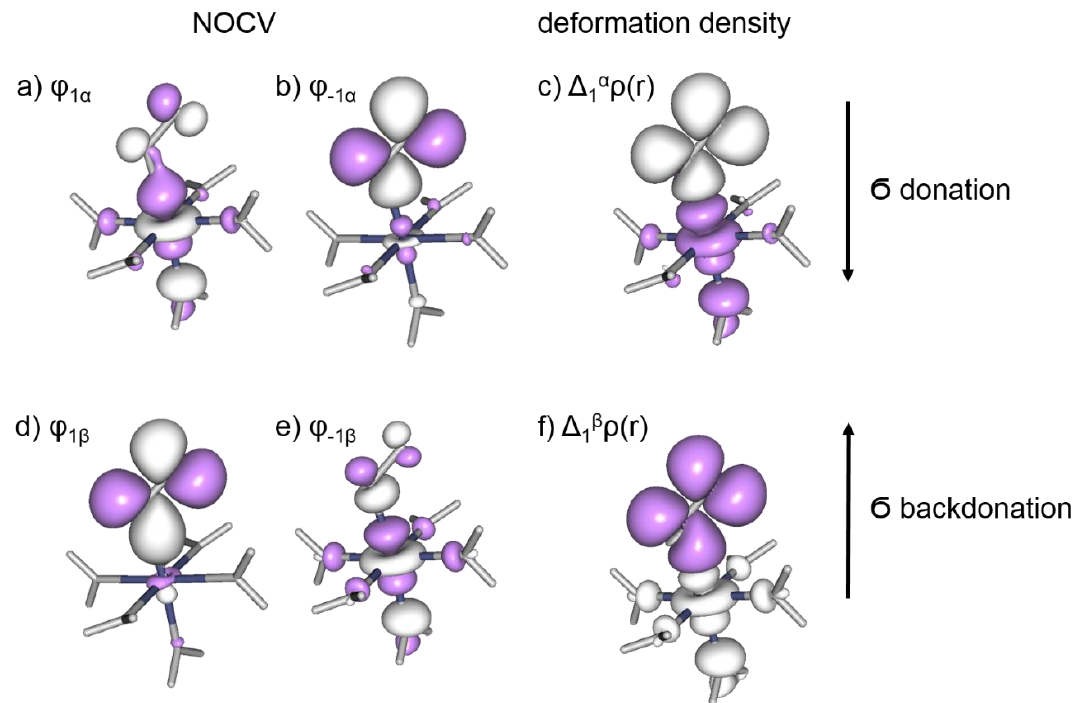
Figure 2. NOCV (pair for α electrons ( a , b ) and for β electrons ( d , e )) and the contribution to the deformation density ∆ ρ (r) ( c , f ) originated from the pairs complementary to NOCV, characterizing the bond between the Co(H 2 O) 52 + fragment and OO ligand. The | ∆ ρ | = 0.05 a.u. contours are shown. White orbitals describe the outflow, and purple, the inflow of electrons.